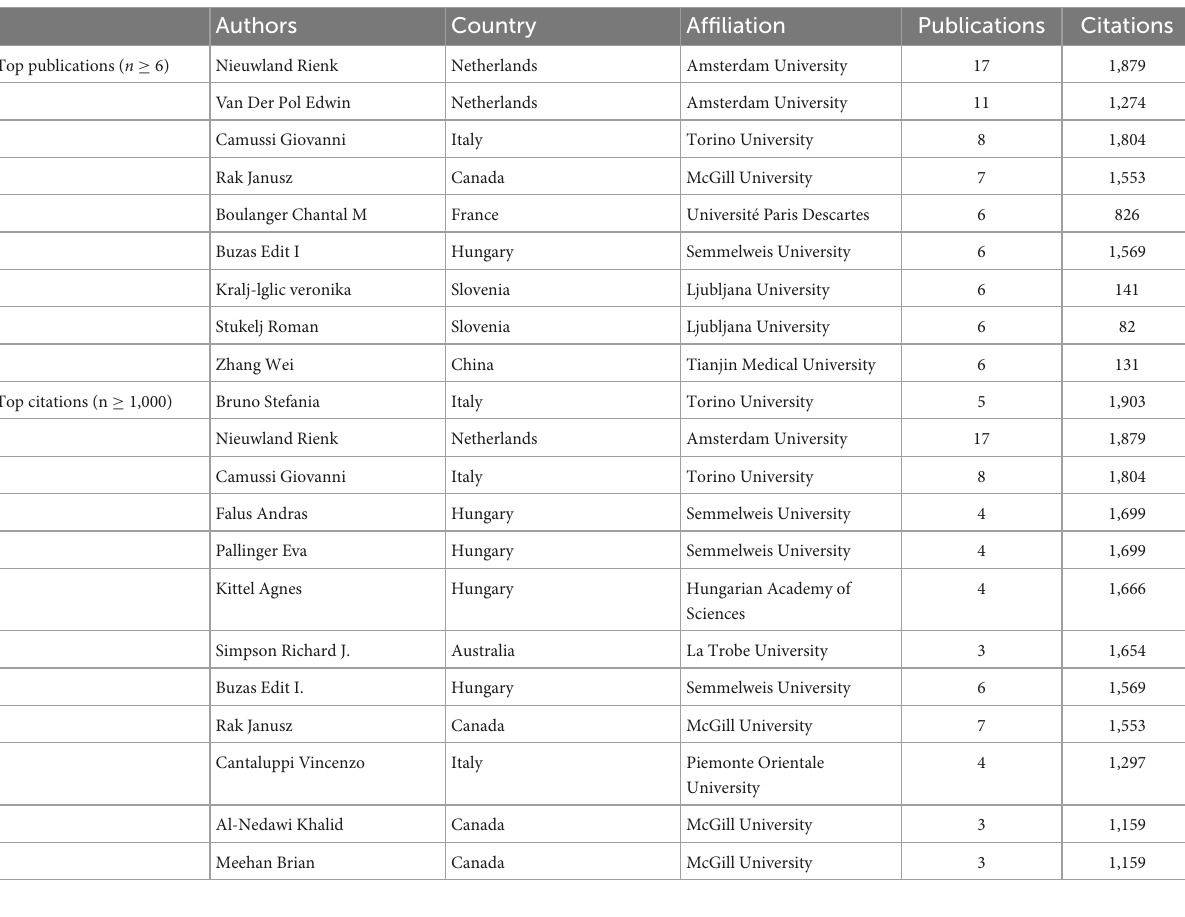
TABLE 5 The top authors in the field of platelet exosomes, ranked by publication and citation numbers.